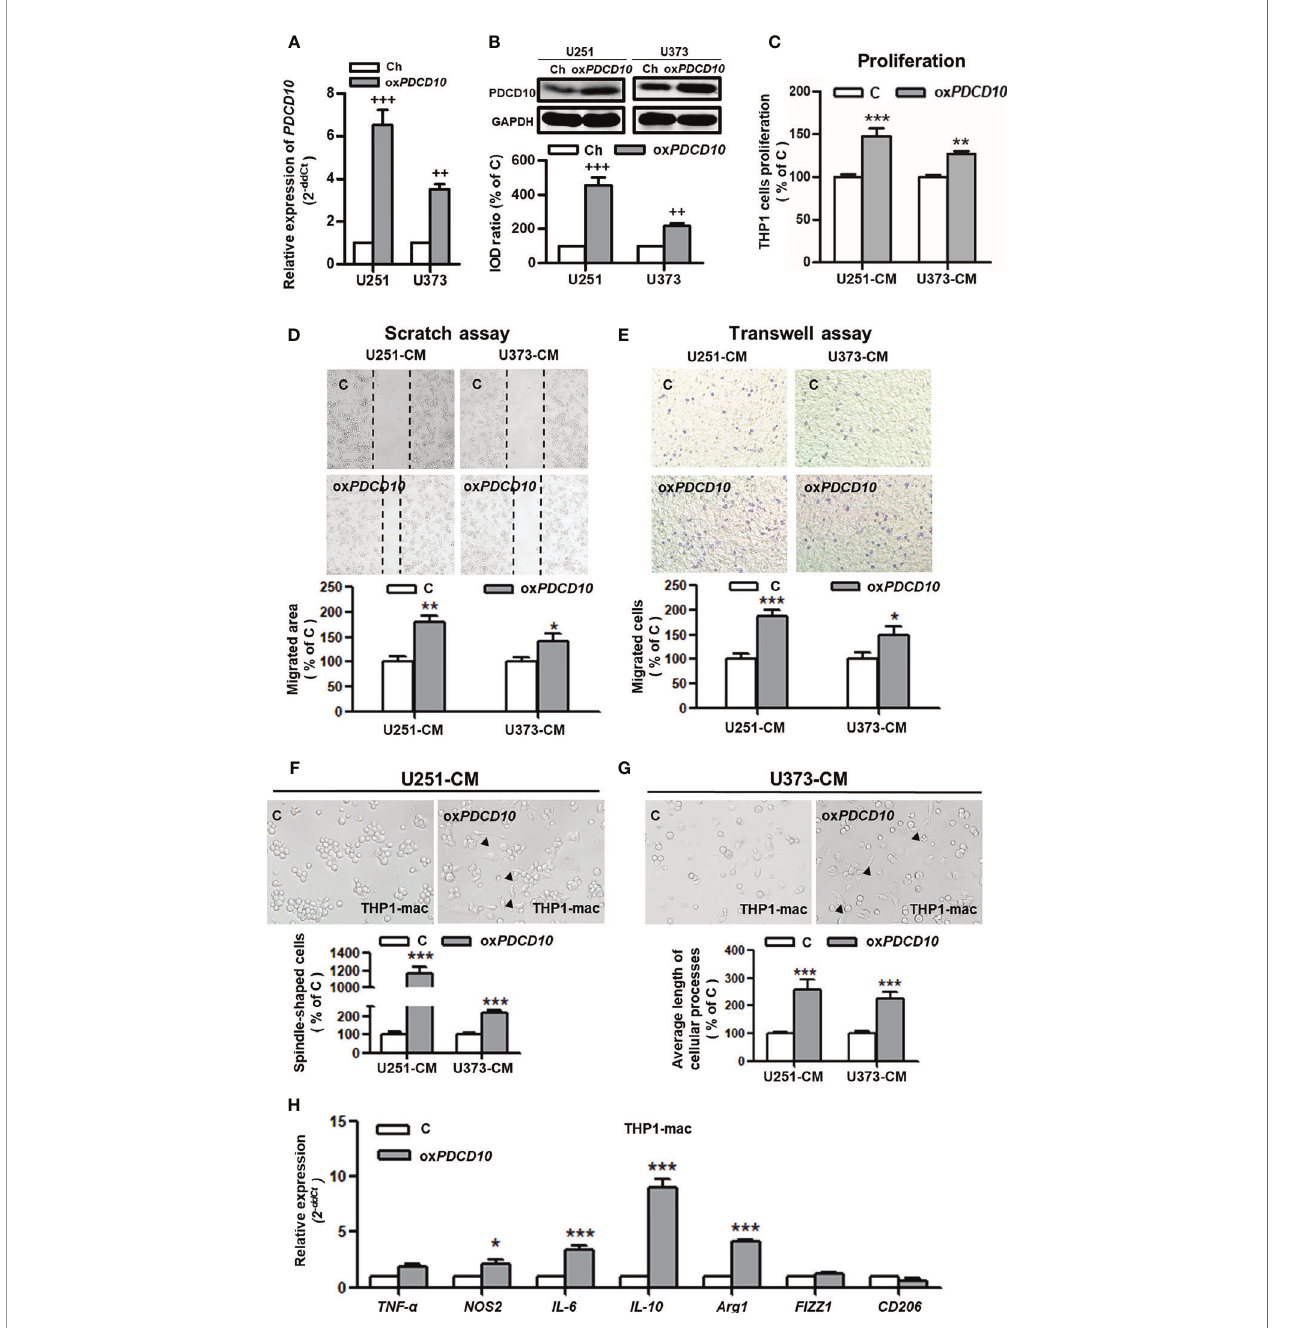
FIGURE 2 | Overexpression of PDCD10 in human GBM cells activated macrophages in vitro . Human GBM cell lines (U251 and U373) were transducted by lentivirus vectors containing human PDCD10 (ox PDCD10 ) and empty vector (Ch) respectively. (A, B) PDCD10 overexpression was con fi rmed by RT 2 -PCR (A) and Western blot (B) . Macrophage-like cells (THP1-mac) were generated by the treatment of human THP1 cells with 100 ng/ml prorbol myristate acetate. Then, cells were incubated with conditioned medium (CM) and control medium derived from ox PDCD10 - (ox PDCD10 ) and control-GBM cells (C) respectively. (C) Cell proliferation was detected by CCK-8 assay. (D, E) Cell migration was measured by scratch assay and transwell assay. For scratch assay (D) , migrated area of THP1-mac cells was measured 48 hours after scratching. To perform transwell assay (E) , THP1-mac cells were seeded into the insert of transwell system with serum-free medium. CM or control medium was added into the lower chamber. After incubation for 24 hours, the migrated cells were counted after crystal violet staining in a high magni fi cation. (F, G) THP1-mac cell morphology study. After incubation with medium derived from ox PDCD10 -U251 (F) or ox PDCD10 -U373 (G) GBM cells, most THP1-mac cells displayed a morphological change including a higher percentage of spindle-shaped cell type as well as a longer cellular process (arrowheads). (H) The relative gene expressions in THP1-mac cells were detected by RT 2 -PCR. ++ p<0.01 and +++ p<0.001, compared with Ch; *p<0.05, **p < 0.01 and ***p < 0.001, compared with (C)